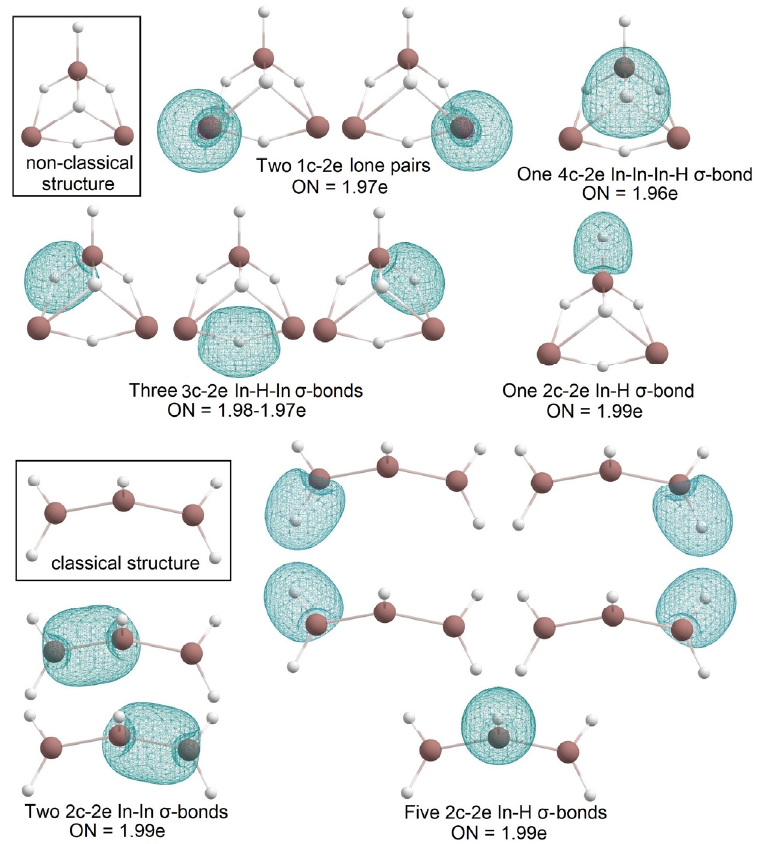
Figure 11. The chemical bonding pattern of In 3 H 5 —non-classical structure (global minimum) and classical structure.